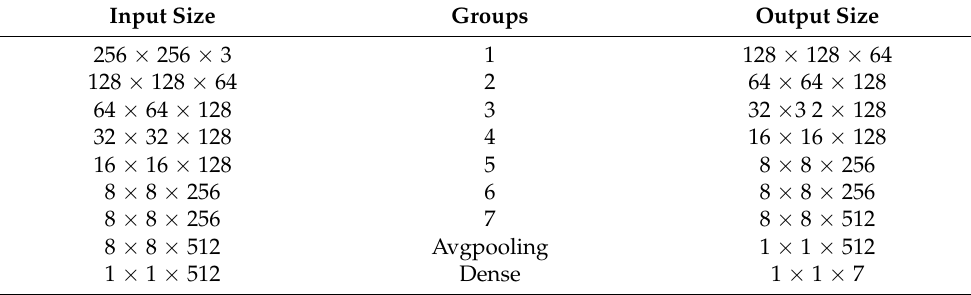
Table 2. Network architecture of the LCNN-CMGF method.